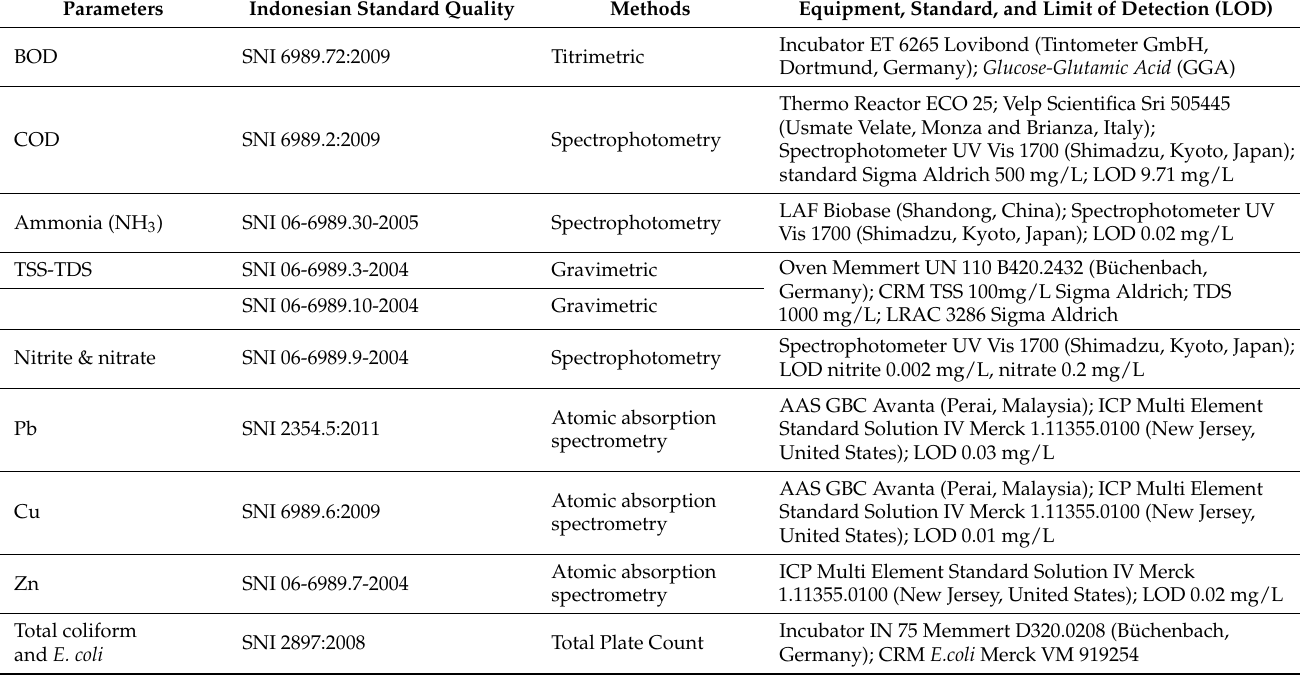
Table 1. Standard method of water